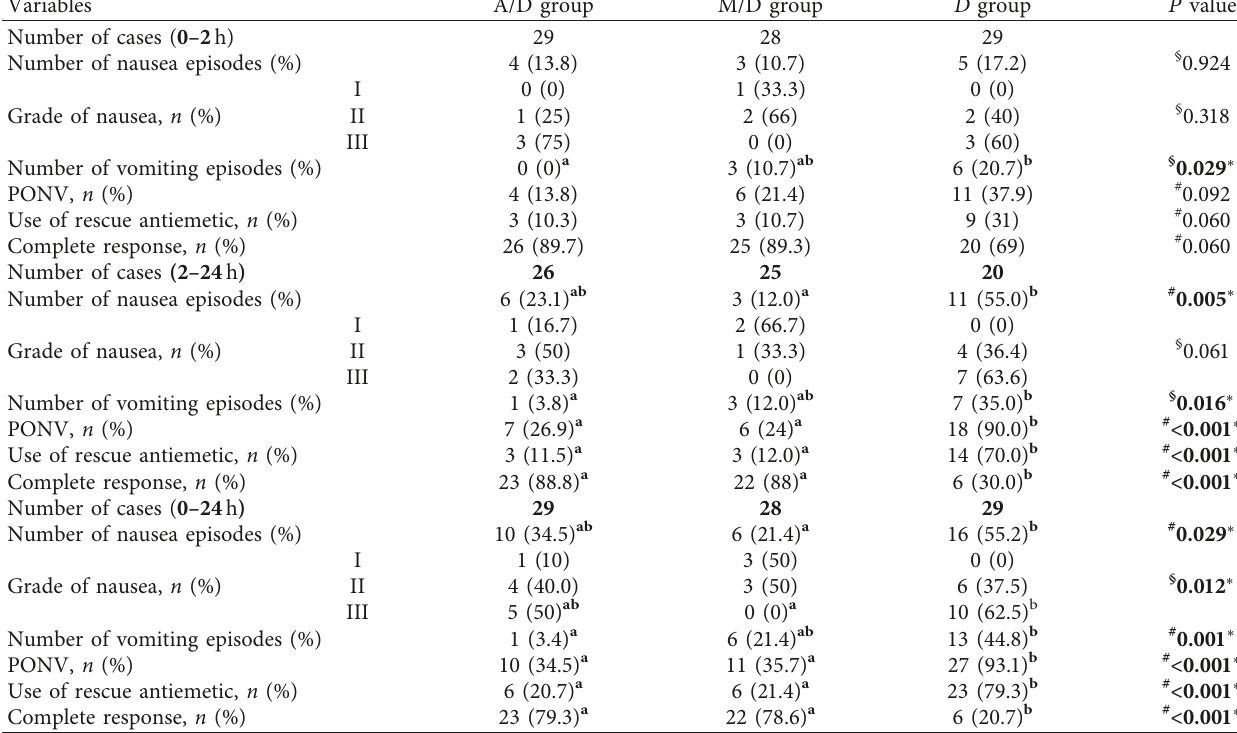
Table 2: Postoperative nausea and vomiting among the studied groups in the first